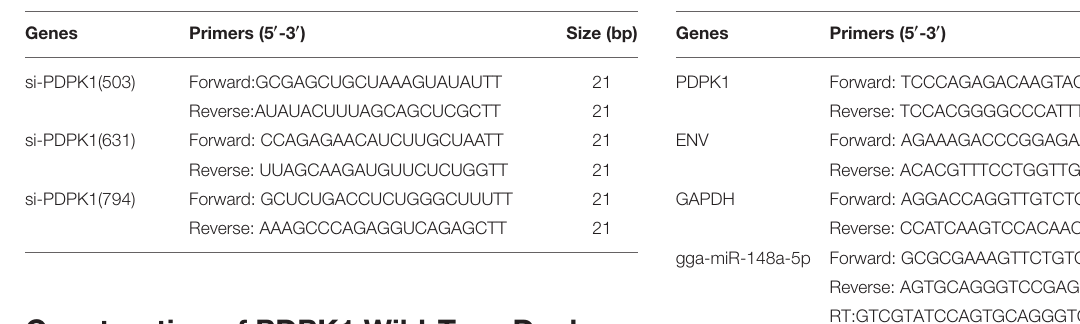
TABLE 1 | Primer sequence. TABLE 2 | Primer sequence for real-time